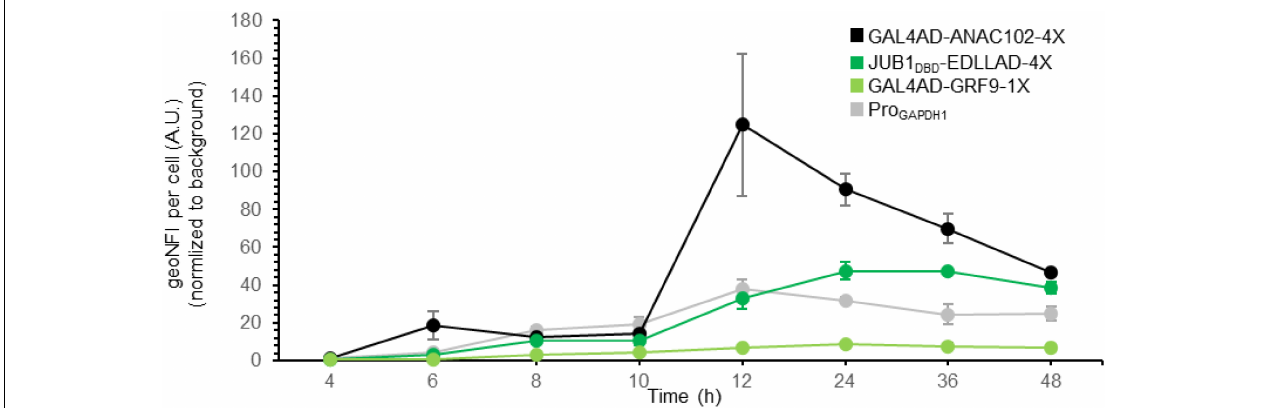
FIGURE 3 | Time course of plant-derived ATF/BS-dependent reporter gene induction. Time course of reporter gene induction, resulting from plant-derived ATFs consisting of GAL4AD and ANAC102 (black), the DBD of JUB1 and EDLLAD (green), or GAL4AD and GRF9 (light green) in combination with “4,” “4,” or “1” copies of their BS, respectively, was compared with the fluorescent output of the constitutive GAPDH promoter (gray). The output of GFP was measured by flow cytometry after 4, 6, 8, 10, 12, 24, 36, and 48 h. The samples were harvested at each time point and analyzed for GFP expression. At each time point, the medium was replaced with the fresh induction medium. EDLLAD, activation domain from plant; GAL4AD, GAL4 activation domain of yeast; GRF9, Growth-Regulating Factor 9; JUB1, NAC TF JUNGBRUNNEN1; ANAC102, A NAC TF 102; DBD, DNA binding site; Pro, promoter. Data are expressed as the geometric mean ± SD of the fluorescence intensity obtained from three cultures, each derived from an independent yeast colony and determined in two technical replicates. Data are normalized to the average geoMFI of the background fluorescence obtained from wild-type JC308. AU, arbitrary units; geoMFI, geometric mean fluorescence. The full data are shown in Supplementary Data 2